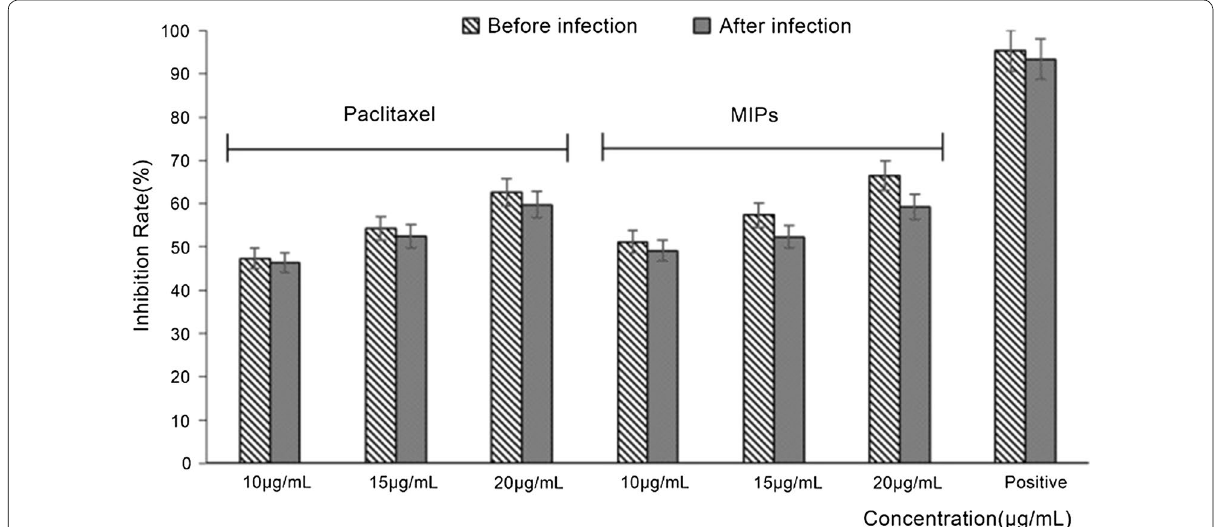
Fig. 4 Inhibitory effects of paclitaxel on HIV-1 entrance activation induced by pseudovirus. “Positive” refers to the positive control AZT